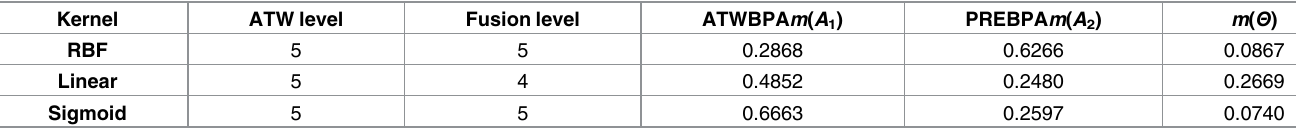
Table 6. The recognition framework of the first sample.